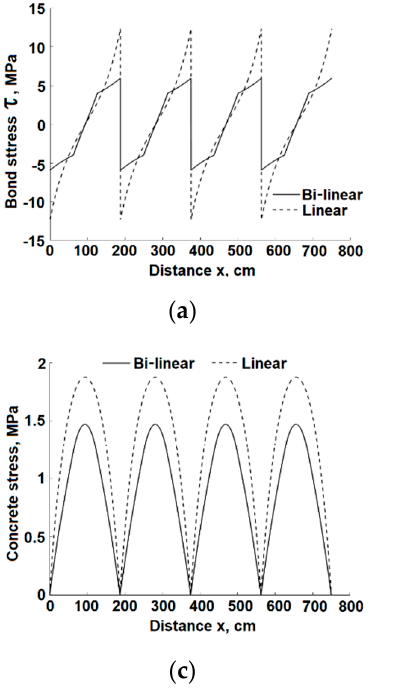
Figure 14. Slip and stresses distributions after third cracking stage ( P = 23.36 kN). ( a ) bond stress;